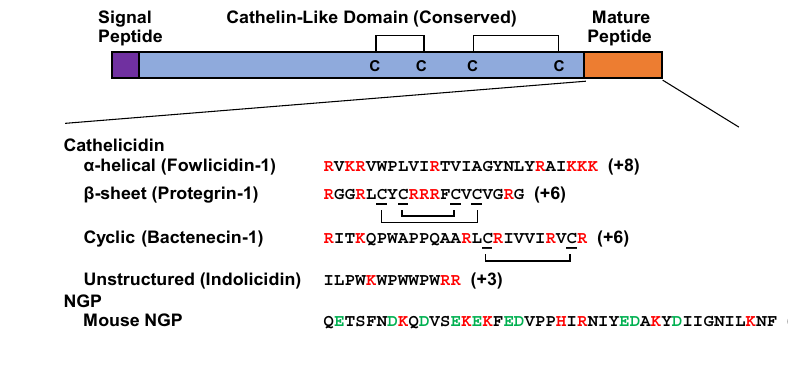
(A) Cathelicidins and Cathelicidin-Related